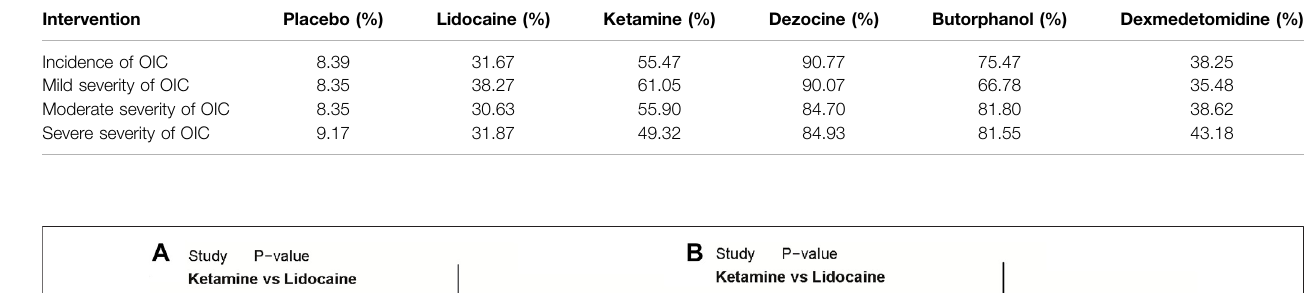
Frontiers in Pharmacology |